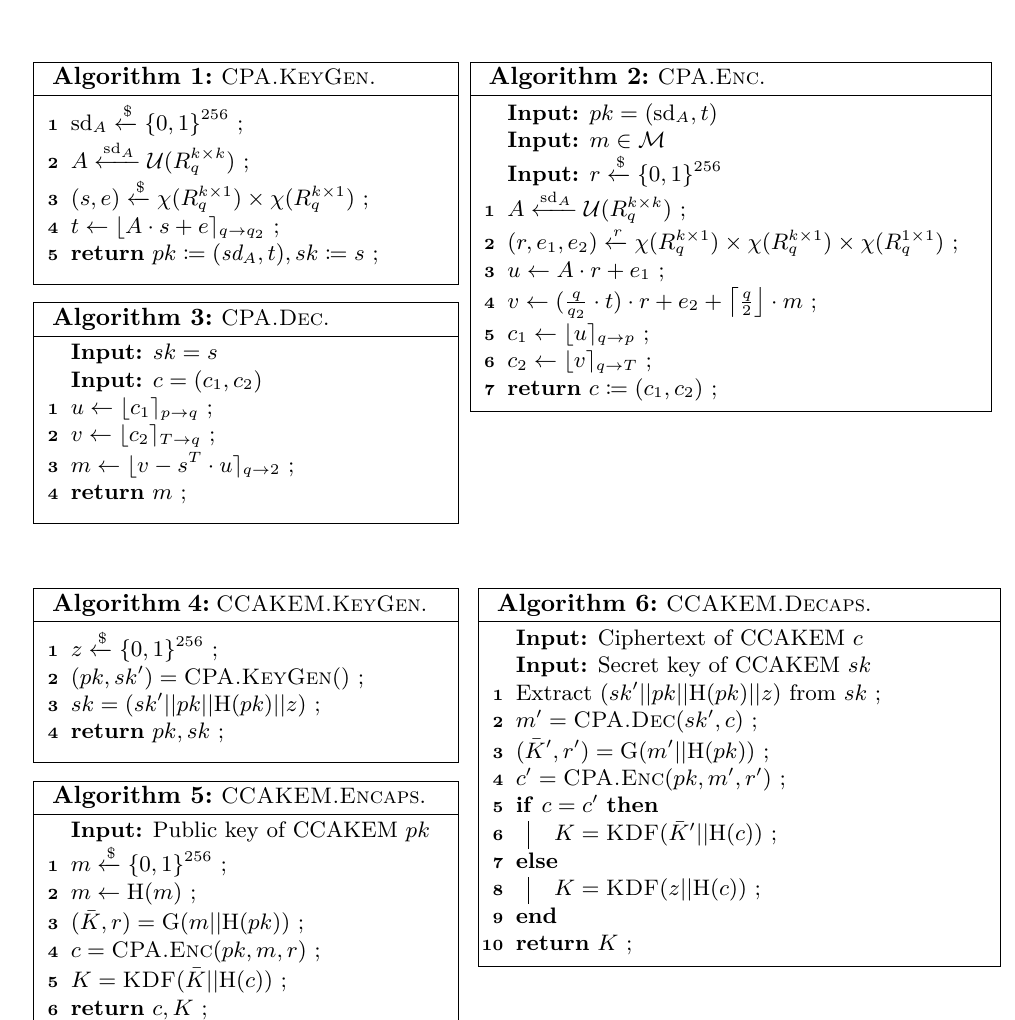
Algorithm 1: CPA.KeyGen .